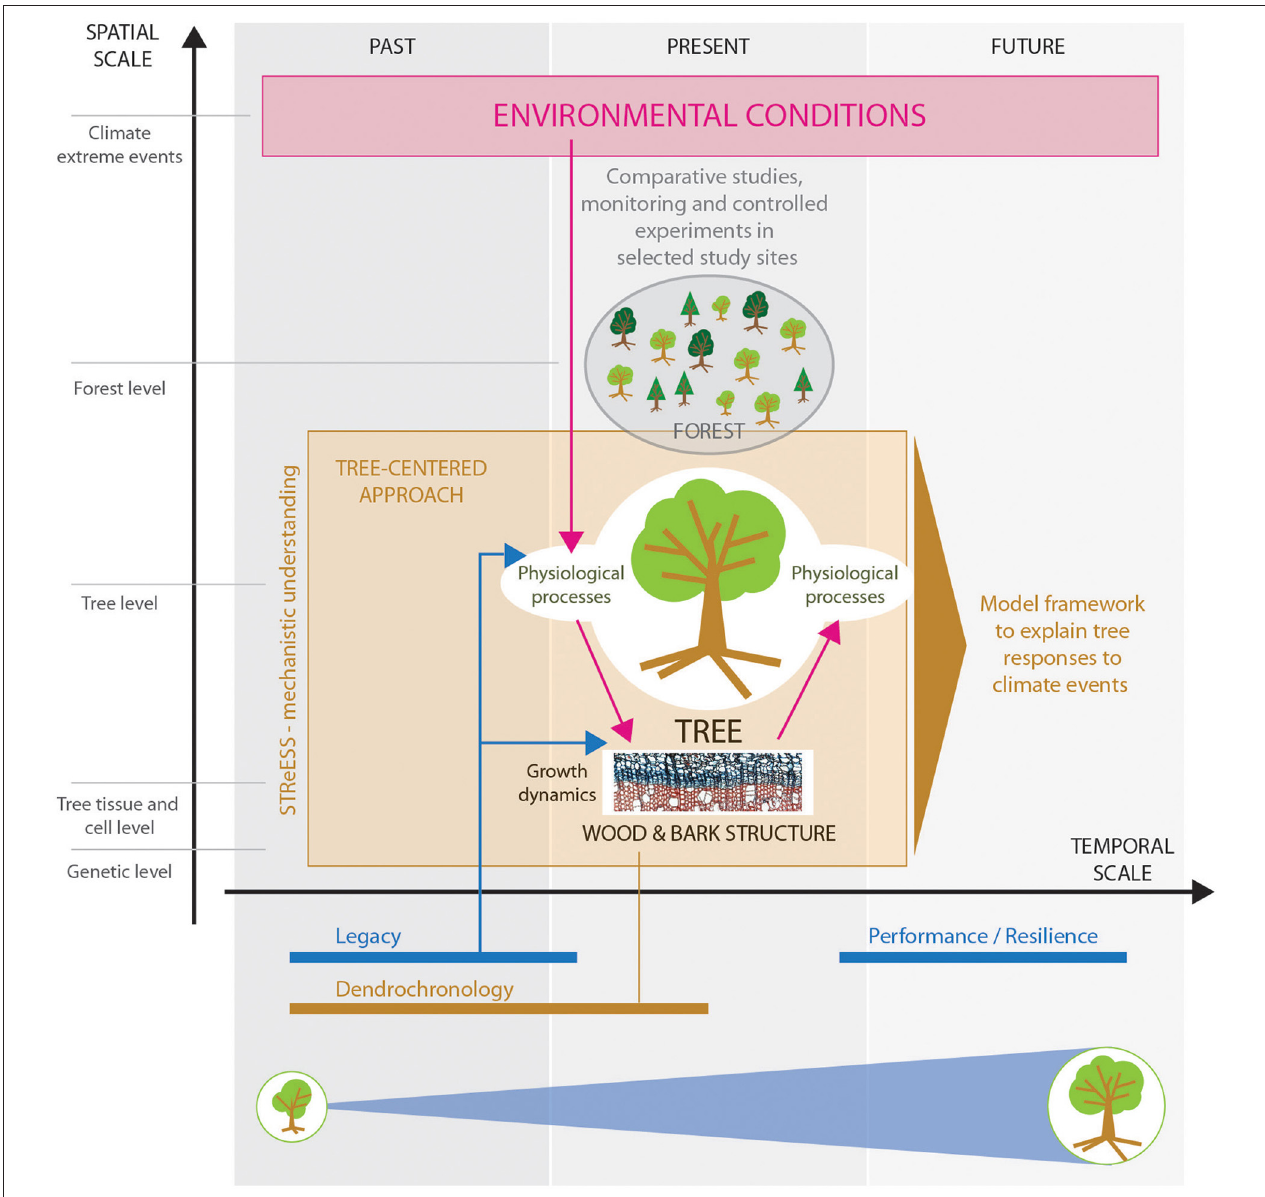
FIGURE 1 | Schematic of the tree-centered approach applied by STReESS to enhance mechanistic understanding. The approach consists of the following interlinked elements: (1) Environmental conditions affect physiological processes, which drive growth dynamics, and results in specific wood and bark structure. (2) Quantity and structure of newly formed wood as assessed by dendrochronology affects whole-tree physiological functioning and performance. (3) Legacy of past environmental conditions and extreme events is imprinted in wood structure, influencing tree functioning, and todays’ tree performance. This is important to assess tree resilience ability. (4) Selection of comparative studies, monitoring, and controlled experiments allow model testing and validation in specific contexts. All four elements are important to assess non-linear trigger-response relations and enable to create a model framework to explain and evaluate tree responses to climate events.